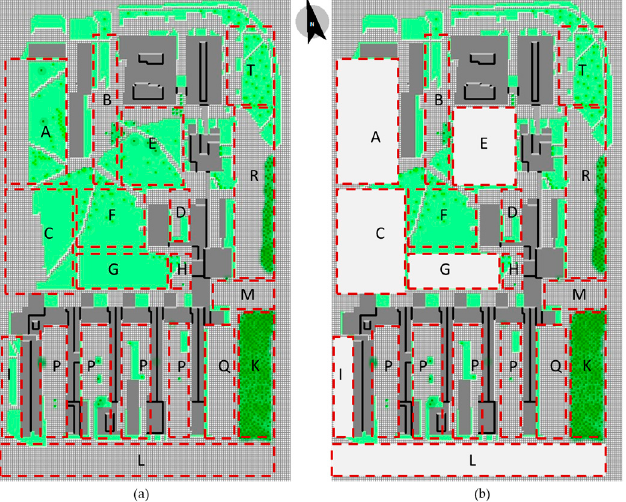
Figure 16. Different areas in the campus, generated in ENVI-met ( a ), areas needing improvement ( b ).